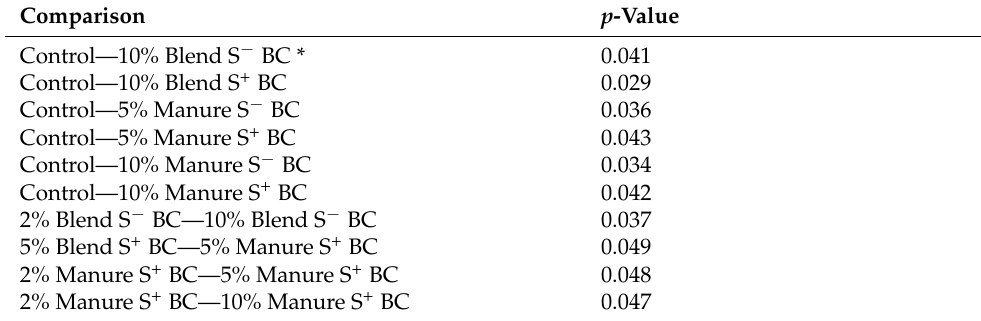
Table 1. p -values for Trifolium incarnatum herbage dry weight vis- á -vis control pots with no biochar. Comparison